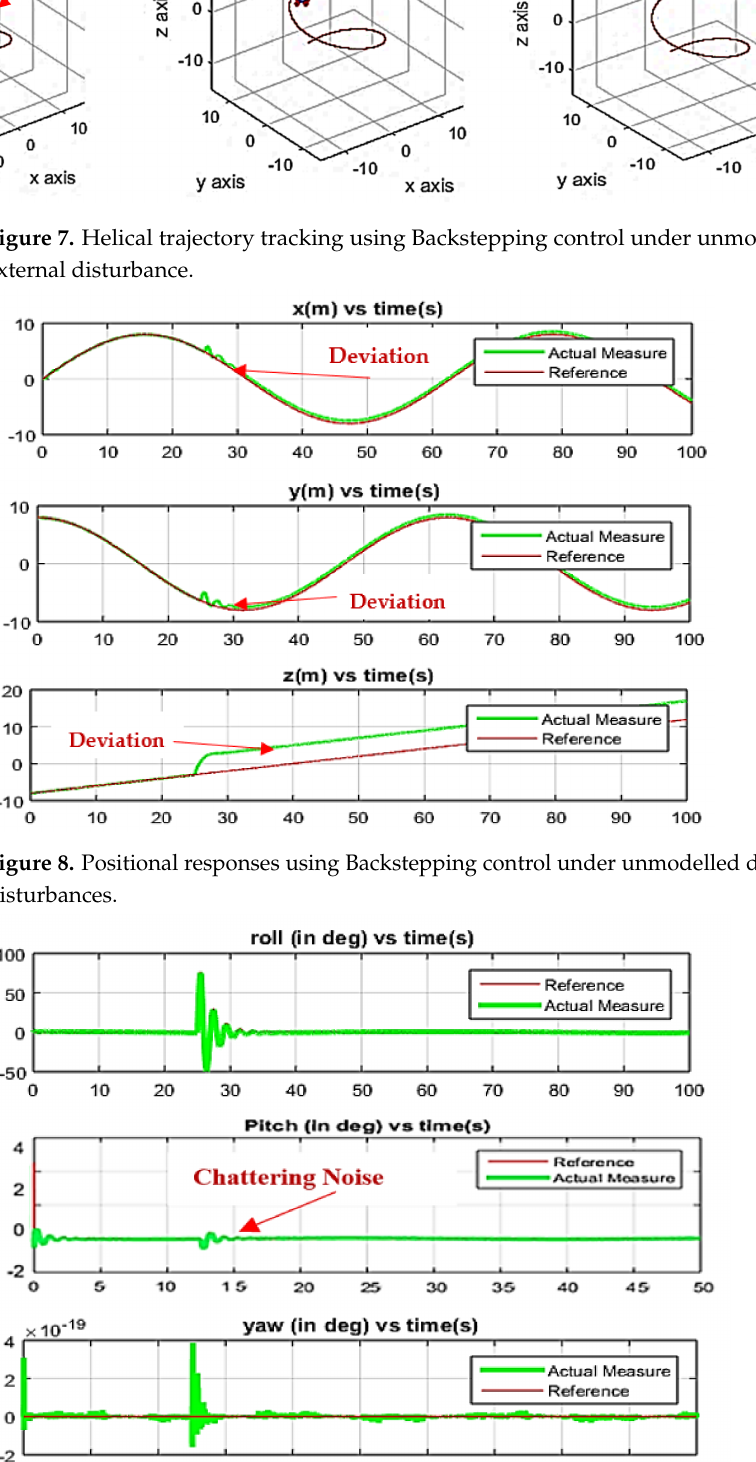
Figure 9. Roll, pitch, and yaw responses using Backstepping control under unmodelled dynamics and external